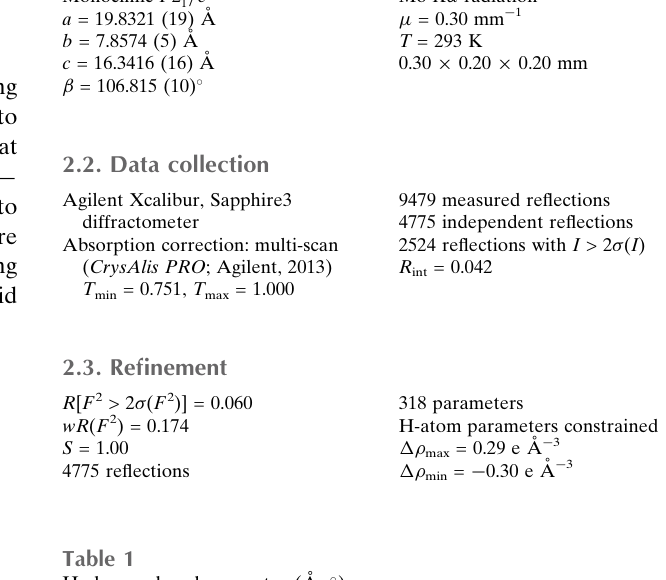
Hydrogen-bond geometry (A˚ , (cid:2)